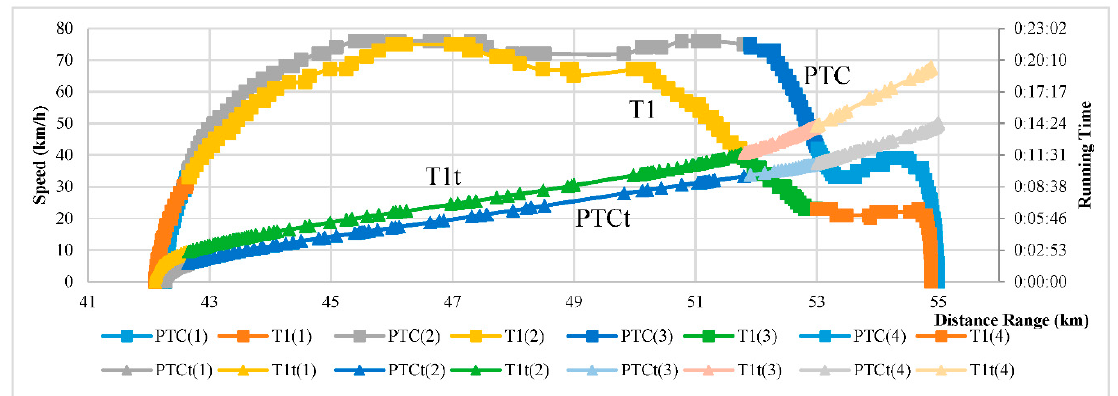
Figure 4. Illustration of 4-fold Driving Segmented Standard Deviation Features (DSSDF). This figure shows the correspondences between sub-segments.